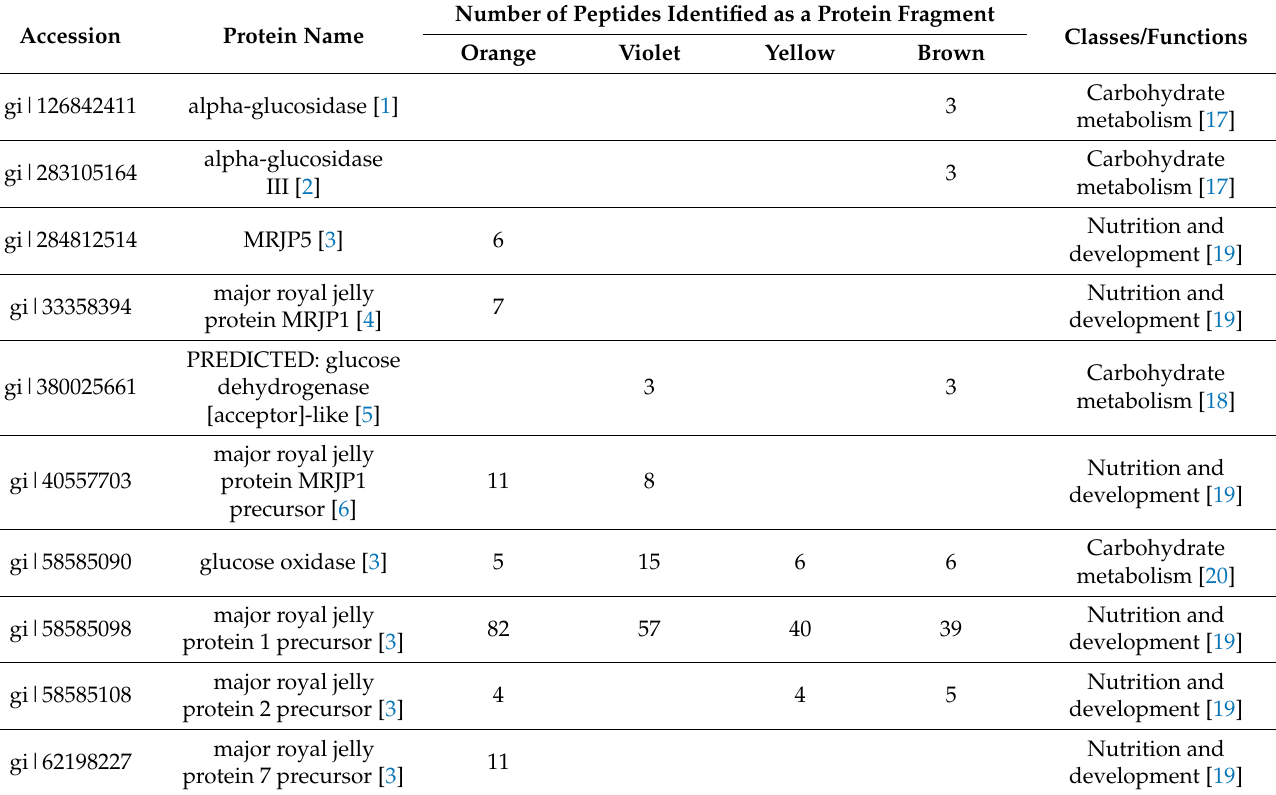
Table 1. Proteins identified in bee pollen classified to Apis spp.; [1]— Apis cerana indica ; [2]—